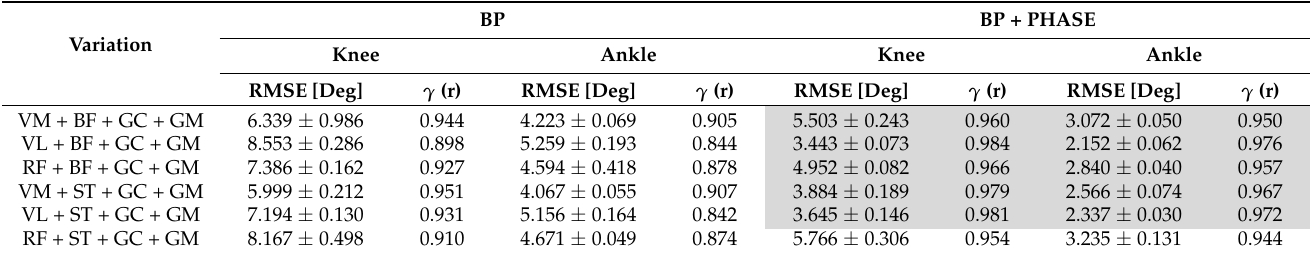
Table 4. The comparison of four muscle combinations for the subject